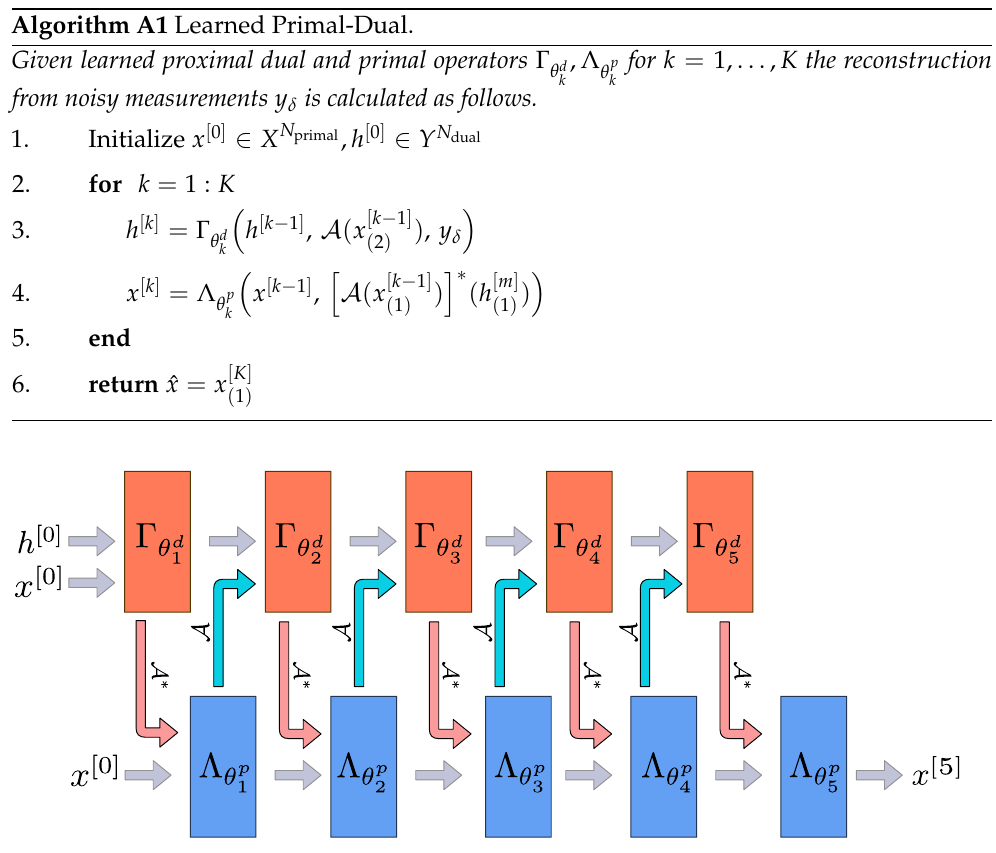
Figure A1. Architecture of the learned primal dual algorithm unrolled for K = 5 iterations. We used a zero initialization for h [ 0 ] and the FBP reconstruction for x [ 0 ] . Adapted from